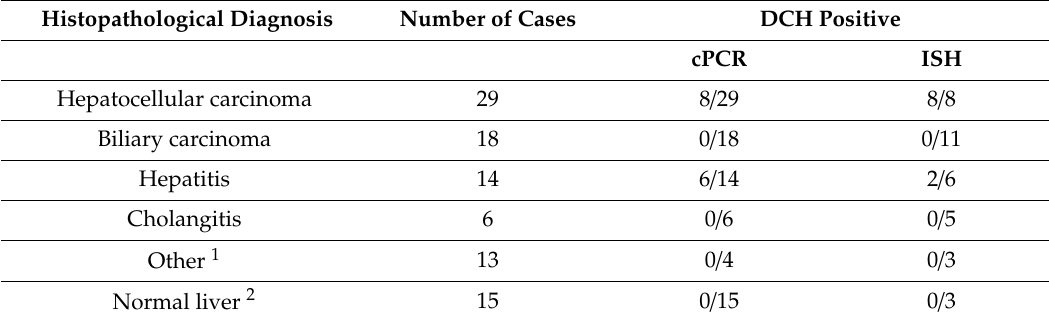
Table 1. Detection of domestic cat hepadnavirus (DCH) in feline liver by PCR and ISH. Histopathological Diagnosis Number of Cases DCH Positive cPCR ISH Hepatocellular carcinoma 29 8 / 29 8 / 8 Biliary carcinoma 18 0 / 18 0 / 11 Hepatitis 14 6 / 14 2 / 6 Cholangitis 6 0 / 6 0 / 5 Other 1 13 0 / 4 0 / 3 Normal liver 2 15 0 / 15 0 /